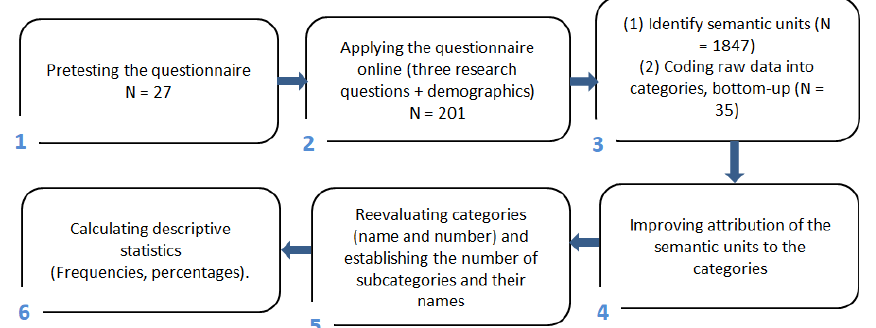
Figure 1. A flow chart indicating how the research was conducted.